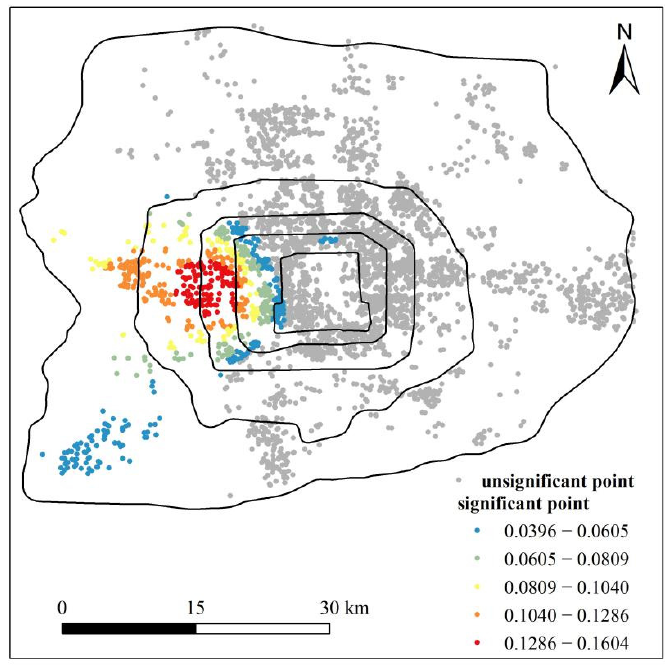
Figure 10. Spatial distribution of the ENTROPY2 influence coefficients in Model 2.